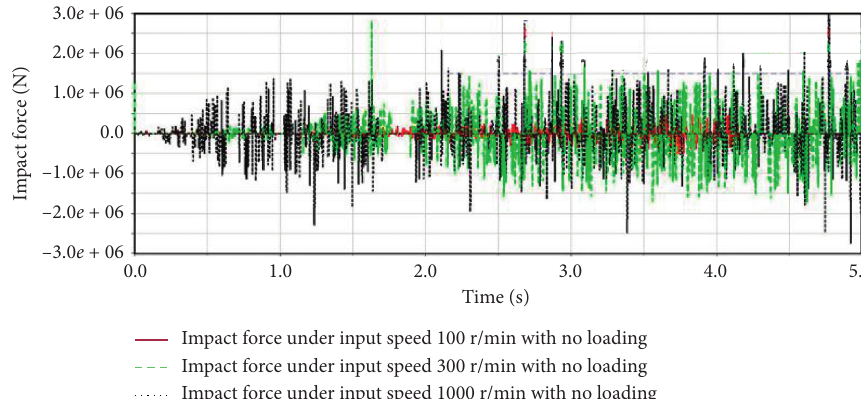
Figure 10: Impact force of first-stage face gear pair with no loading.